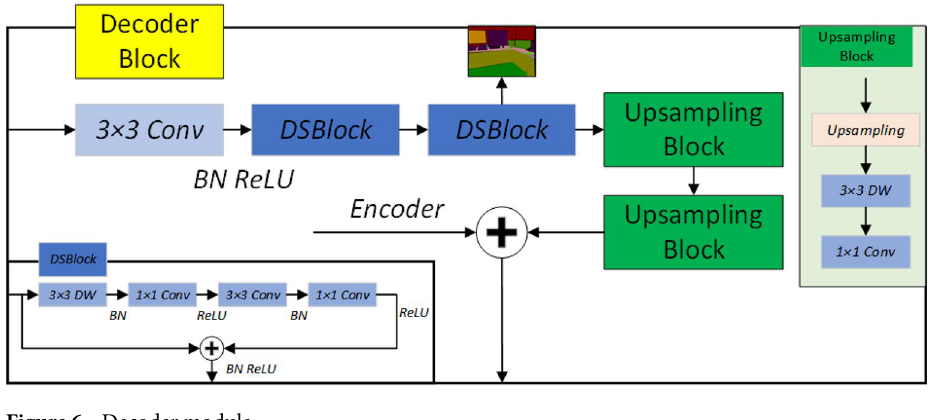
Figure 6. Decoder